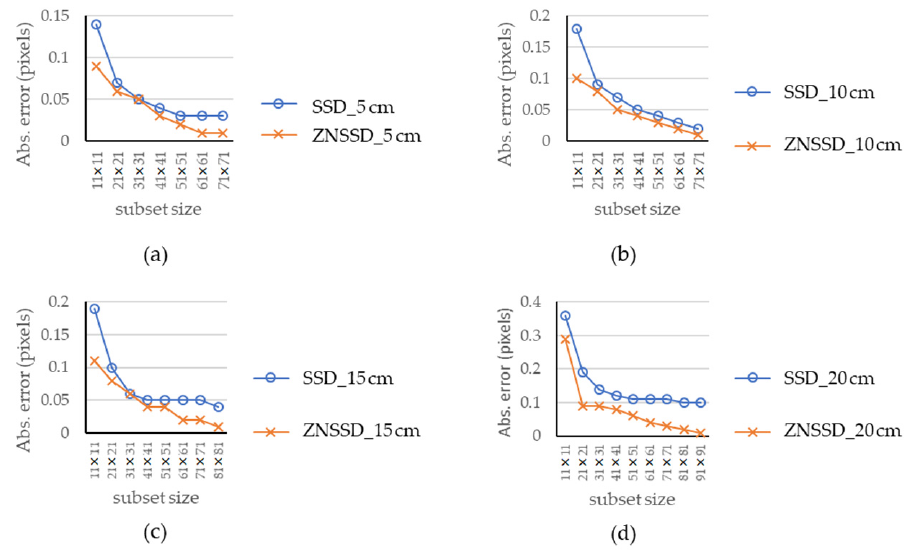
Figure 9. Comparison of average abs. errors under different criteria for ( a ) 5 cm, ( b ) 10 cm, ( c ) 15 cm, ( d ) 20 cm.